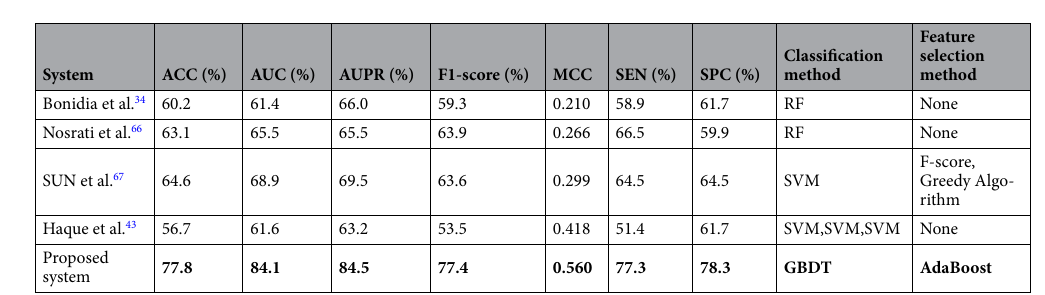
Table 11. The performance comparison, classification methods, and feature selection methods used in state- of-art systems compared with the proposed system based on the lncRNA dataset. Significant values are in bold.